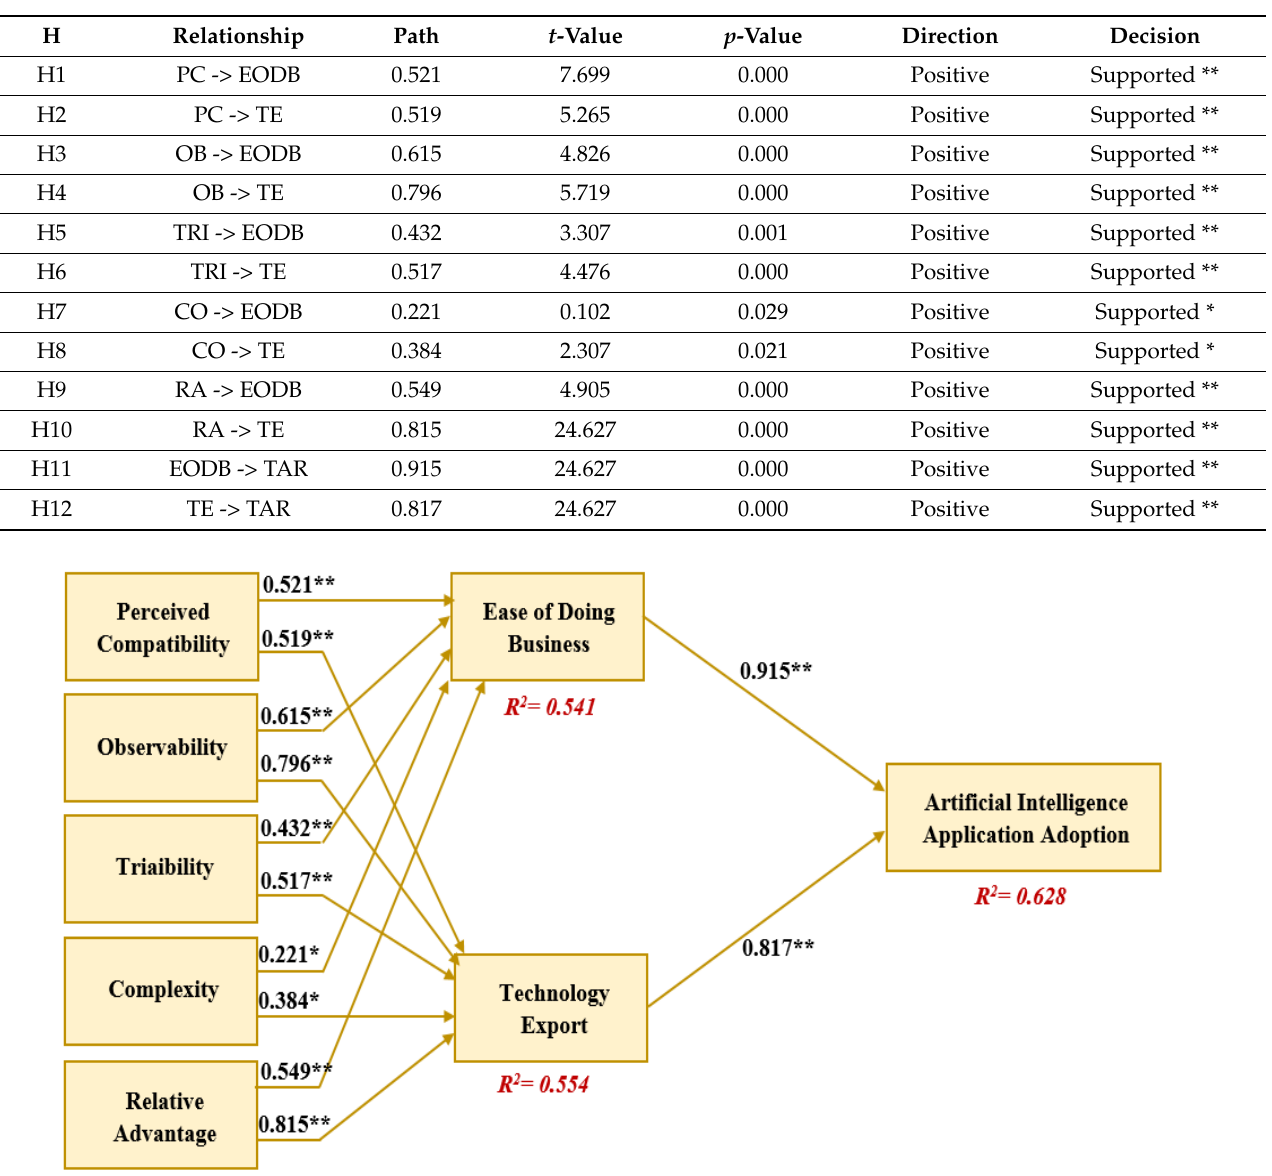
Table 9. Hypotheses testing of the research model (significant at ** p < = 0.01, * p < 0.05).